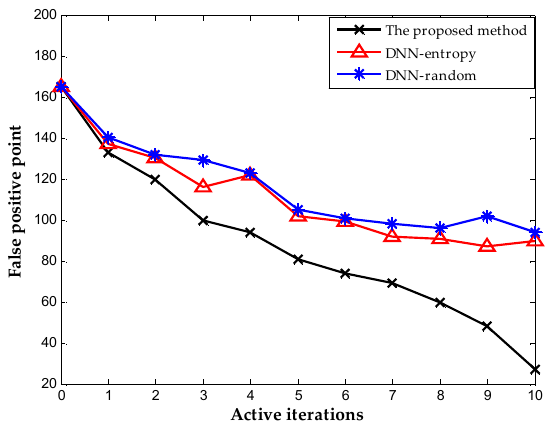
Figure 9. Classification accuracy during each iteration.